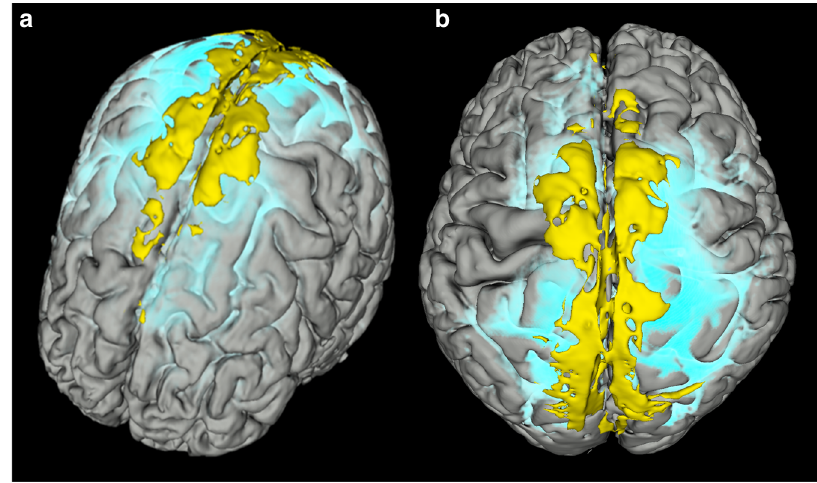
Fig. 1 3D representation of parasagittal dura as de fi ned from T2-FLAIR. The brain is shown in oblique coronal view ( a ) and viewed from above ( b ). Parasagittal dura (dark yellow) as de fi ned from T2-FLAIR and co-registered with rough segmentation of the brain (gray) and tracer enhancement in CSF (light blue) from T1 GRE at 48 h after intrathecal administration. The CSF tracer propagated toward the upper brain convexities and parasagittal dura at late time points (at 24 h and particularly at 48 h). A video-animation presenting the full longitudinal extension of parasagittal dura is presented in Supplementary Movie 2. Images: Tomas Sakinis, MD.